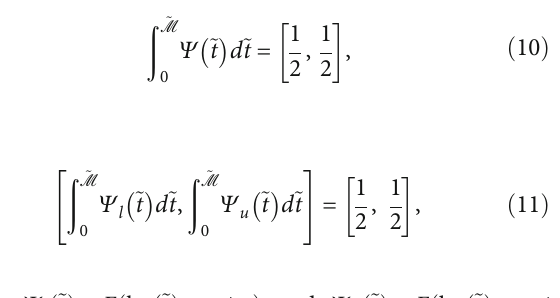
Figure 3: Reliability function of the NLD with neutrosophic parameters (a) σ ~ the function ξ ð t Þ of the NLD would be displayed as shown in Figure 3. This function may be used to determine the failure rate function, the conditional function, and the g PDF .